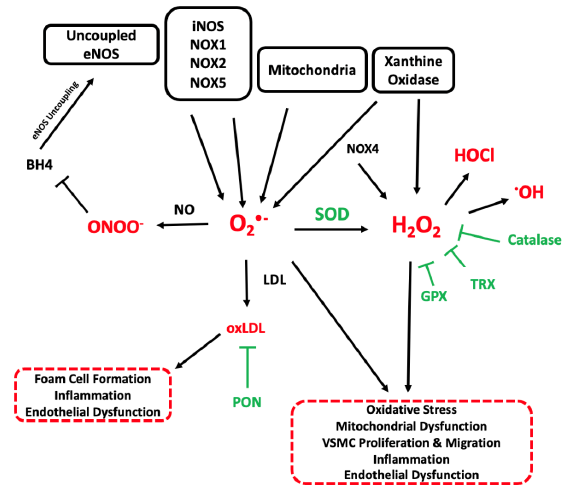
Figure 2. Overview of Vascular Sources and Functions of ROS in Atherosclerosis.